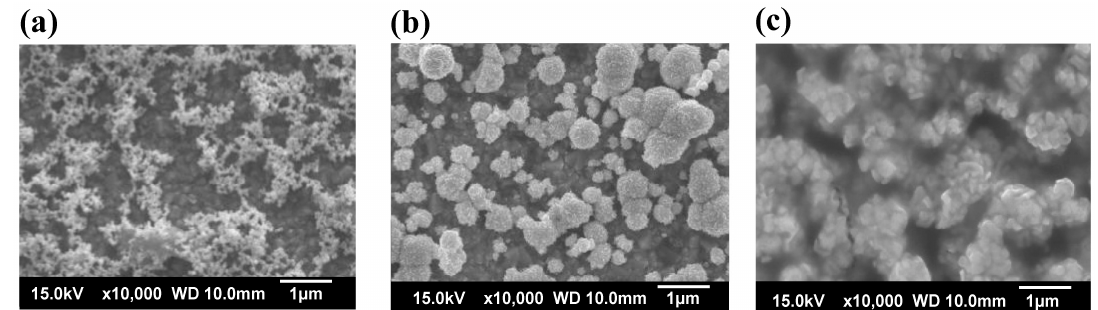
Figure 2. SEM images of ( a ) the Pt electrode fabricated through thermal decomposition; ( b ) the Pt electrode fabricated through electrochemical deposition; and ( c ) the Pt electrode fabricated through chemical reduction.